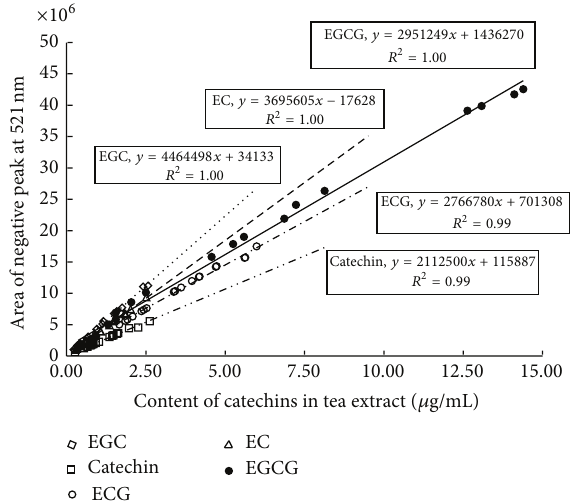
Figure 9: DPPH-scavenging activities of different catechins.